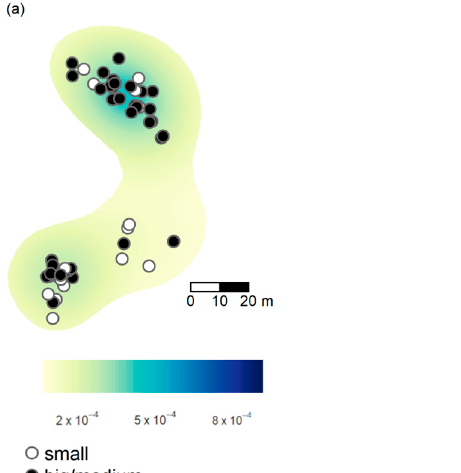
Figure 4. Kernel-smoothed density of large/medium Myrmica colonies at the end of larval develop- ment, in Kosy ń ( a ). Panel ( b ) shows the significance of the segregation (join count statistics, J sb ) be- tween big-medium nests (grouped together) and small nests. In case of significant segregation, ob- served values must be smaller than expected.